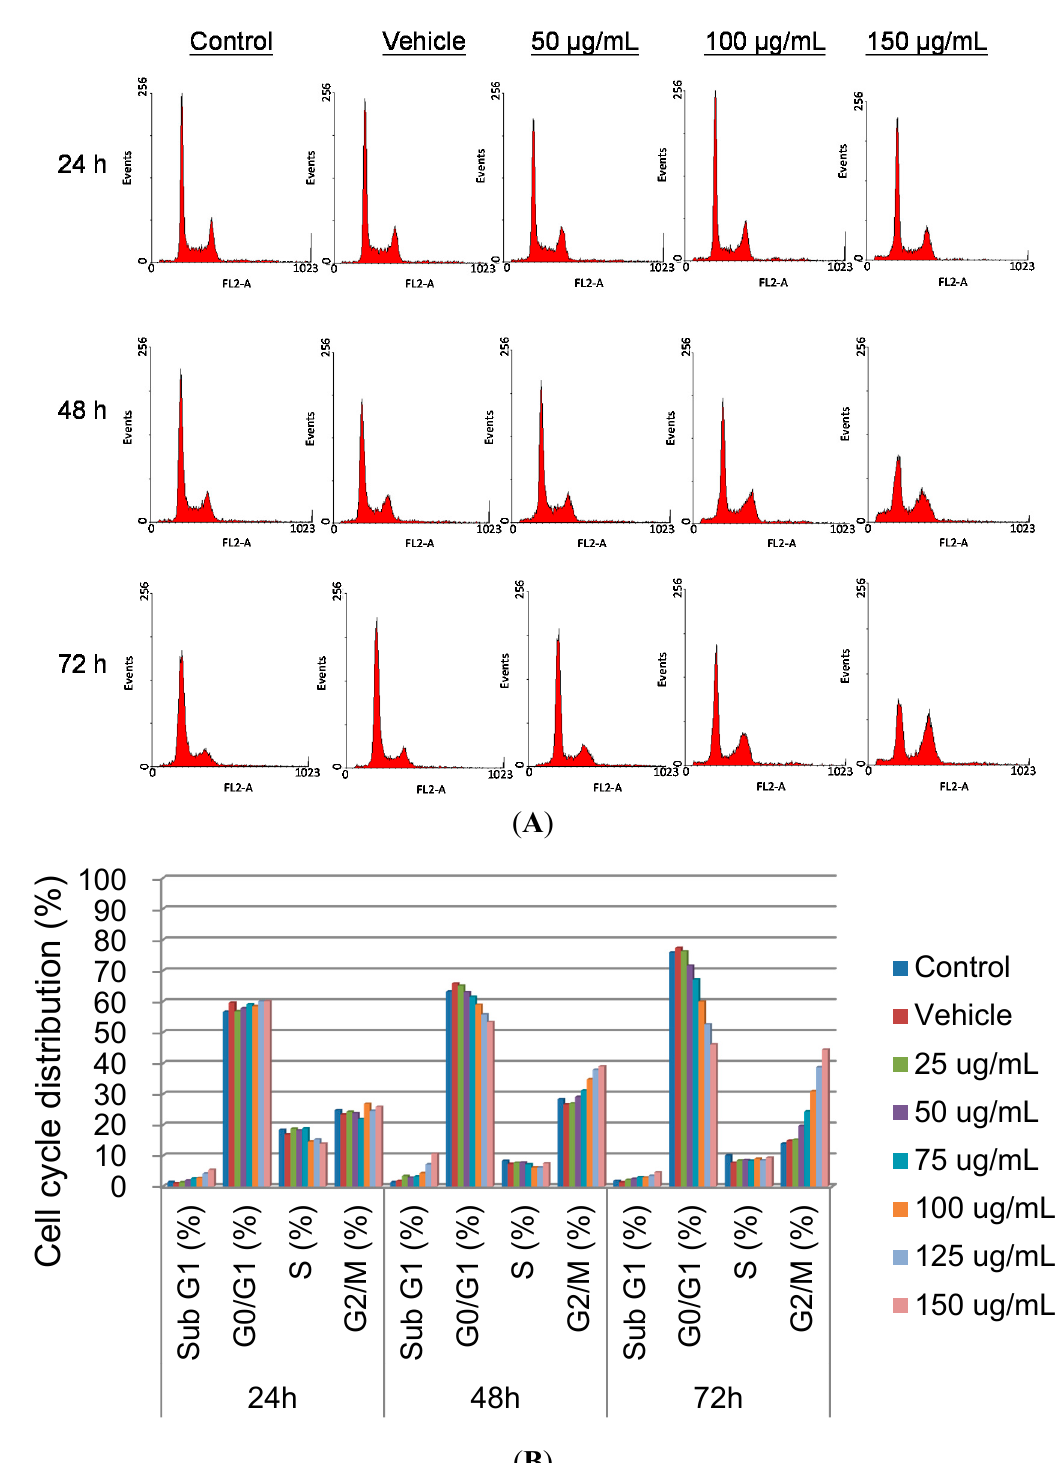
Figure 2. Effect of SOE on cell-cycle progression in RL95-2 cells. ( A ) Cell cycle analysis of RL95-2 cells under treatment with different SOE concentrations for various durations by flow cytometry. The RL95-2 cells (2 × 10 5 cells/well) were incubated with 0–150 μ g/mL of SOE for 24, 48 and 72 h, as indicated in each graph. Cells were suspended in PBS containing 20 μ g/mL PI, 0.2 mg/mL RNase A and 0.1% Triton X-100 at 4 °C for 12 h. The stained cells were analyzed by flow cytometry; ( B ) Cell distribution at different phases of cell cycle. The percentage of each phase was analyzed using WinMDI 2.9